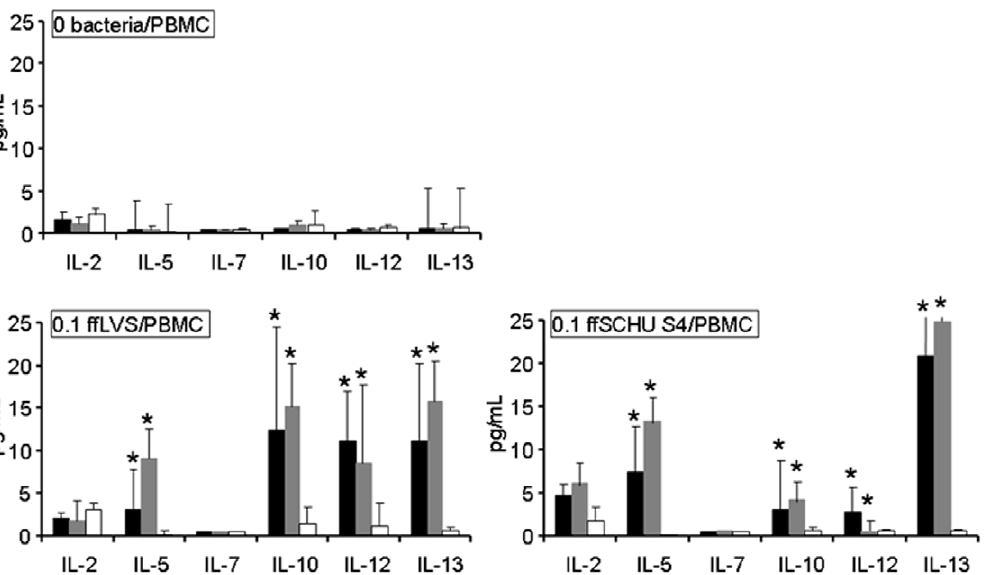
Figure 2. Levels of cytokines secreted by human PBMC after recall stimulation with ffLVS or ffSchu S4 for five days. Cytokine concentrations were measured in cell culture supernatants using multiplex analysis. Median values 6 SEM from PBMC samples of 14–16 individuals per donor group are shown (black bars indicate convalescent patients; grey bars indicate LVS vaccinees; white bars indicate naı¨ve donors). Statistically significant differences between immune and naı¨ve donors are marked by asterisks ( P , 0.05). For IL-7, 36 out of 40 values were below the detection limit and therefore not included in the data analysis.